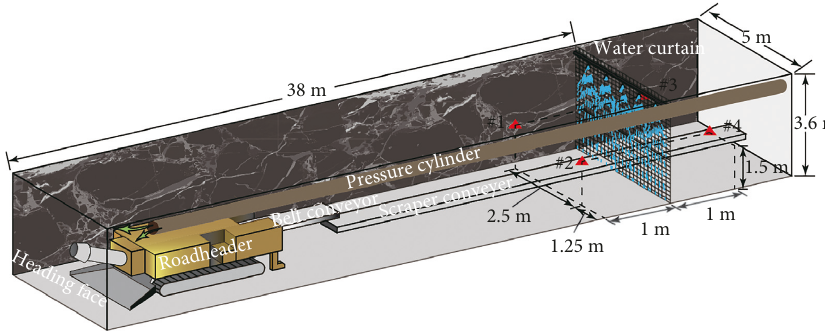
Figure 9: Layout of the water curtain and measurement points in the coal mine roadway.